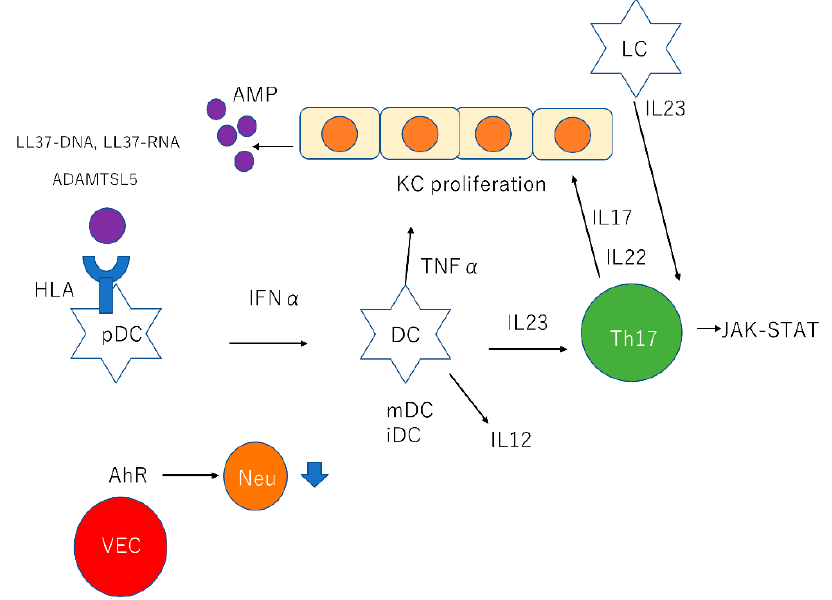
Figure 1. Summary of pathogenesis of psoriasis. KCs produce AMPs such as β -defensins, S100 proteins, and cathelicidin. LL37 and ADAMTSL5 are considered to be as autoantigens. LL37 – DNA complexes stimulate pDCs, and pDCs secrete IFN α . LL37-RNA complexes stimulate mDCs and mDCs produce TNF α , IL23, and IL12. IL23 stimulates Th17 cells and Th17 cells produce IL17 and IL22 through the JAK-STAT pathway. LCs also secrete IL23 and stimulate Th17 cell. AhR in cutaneous VECs downregulate neutrophil recruitment. KC: keratinocyte; AMP: antimicrobial peptides;